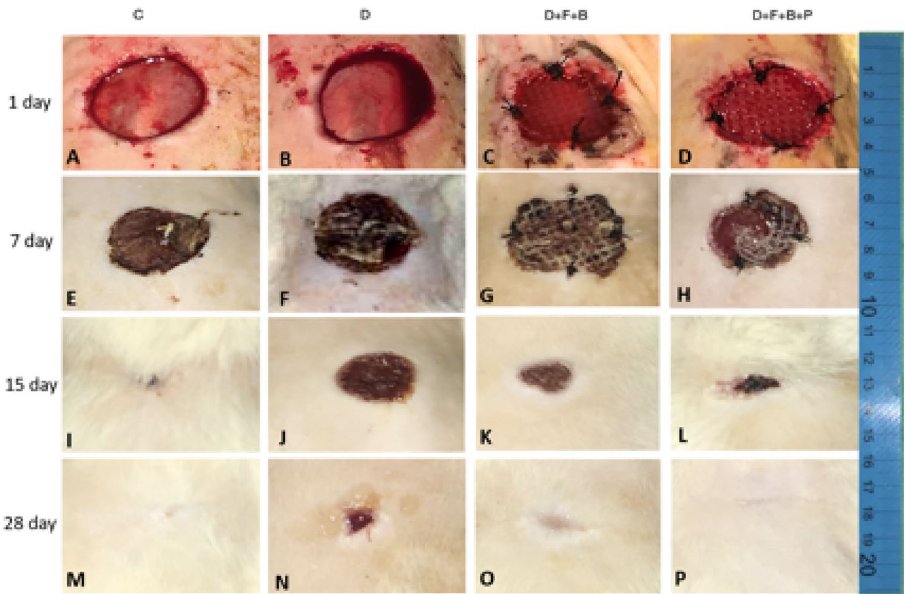
Figure 7. Quantification of wound closure rate. Gross digital camera images illustrating wound closure area in Control, diabetic, D + F + B, and D + F + B + P at the different time points. The pictures show that repairing process at the 1st, 7th, 15th and 28th day in the study